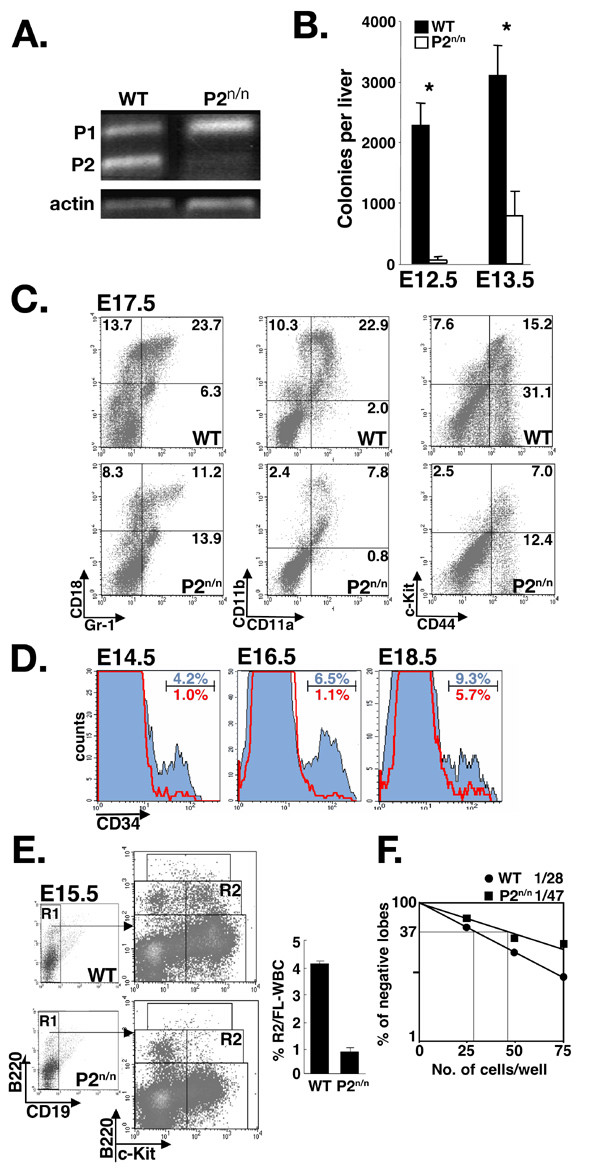
P2-mediated embryonal expression of Runx1 is required for development of FL HPC. (A) RT-PCR analysis of RNA from E13.5 FL cells of WT and P2neo/neo embryos. P2-mediated transcription in P2neo/neo was largely attenuated, whereas P1-mediated transcription was apparently unaffected. (B) Colony forming activity of FL hematopoietic stem/progenitor cells. Colonies (>30 cells in size) were scored on day 7 of incubation. Shown are average numbers of colonies per FL ± S.E. of at least three different WT or P2neo/neo embryos at E12.5 and E13.5. The difference between WT and P2neo/neo colony number is significant (*) at P < 0.001 by Student's t test. (C and D) Altered expression of surface antigens on P2neo/neo FL HPC. (C) Expression profiles of Gr-1, CD18, CD11b, CD11a, CD44 and c-Kit, in FL HPC from E17.5 WT and P2neo/neo embryos. Representative data of at least three different experiments are shown as FACS dot plots; percentages of cells in each quadrant are indicated. Note the 2-fold decrease in the proportions of Gr-1+/CD18+ and CD11a+/CD11b+ (left panels) as well as CD44+/c-Kit+ (right panel), FL cells in P2neo/neo compared to WT. (D) Proportion of CD34+ FL HPC. Profiles of WT and P2neo/neo FL HPC, filled (blue) and unfilled (red) histograms, respectively, at E14.5, E16.5 and E18.5. Shown are representative results of at least three different experiments. Numbers at the upper right corners are percentages of CD34+ cells in WT (upper) and P2neo/neo (lower). Note the marked decrease in the proportions of P2neo/neo CD34+ HPC. (E) Analysis of committed FL T-cell precursors (TCPs). FACS analysis showing the distribution of B220+/c-Kit+/CD19- FL HPC of E15.5 WT and P2neo/neo embryos. Gated CD19- precursors (R1) were analyzed for c-Kit and B220 expression. Note the 4-fold decrease in the proportions of c-Kit+/B220low/D19- TCPs (R2) in P2neo/neo FL HPC. Data shown on the right are average ± S.E. of four independent experiments using four different mice. The difference between the percentages of TCPs from WT and P2neo/neo FL HPC is significant at P < 0.005 by Student's t test. (F) Reduced capacity of P2neo/neo FL HPC to colonize FTOC. Isolated E15.5 FL HPC from WT or P2neo/neo embryos were set to differentiate, under limiting dilution conditions, for 16 days in E14.5 WT FTOC. Shown are percentage of unsuccessfully populated lobes per cultured cells and the calculated frequencies of three different independent experiments.